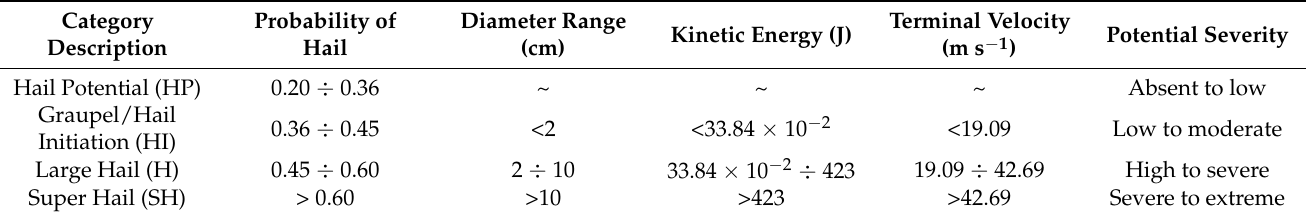
Table 1. MWCC-H hail categories as a function of the kinetic energy and potential severity at the